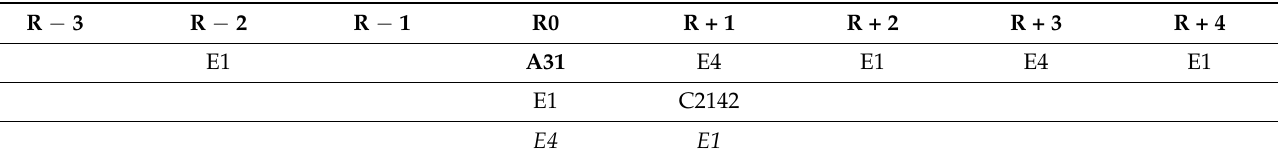
Table 5. Conditioned behaviors associated with the behavior of showing awareness of other people’s emotional reactions